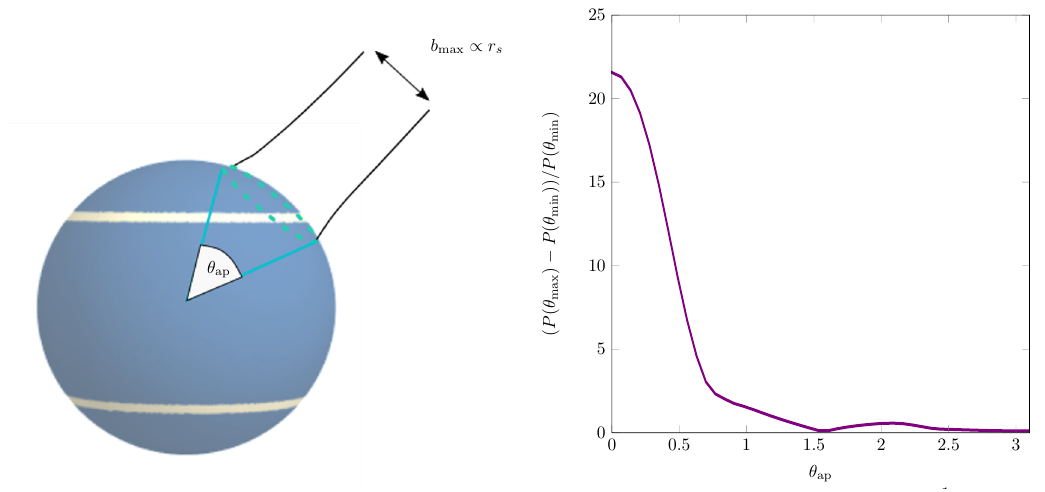
Figure 10 . Gravity in a toy analytic example. We display the power coming from a circle on a spherical emission surface subtended by an angle θ ap . We choose an emission surface (left pane) with two bright strips angular size ∆ θ = 0 . 01 at positions θ = ± π/ 4 . The right panel shows the resulting angular variation in the power with observing direction θ as a function of θ ap